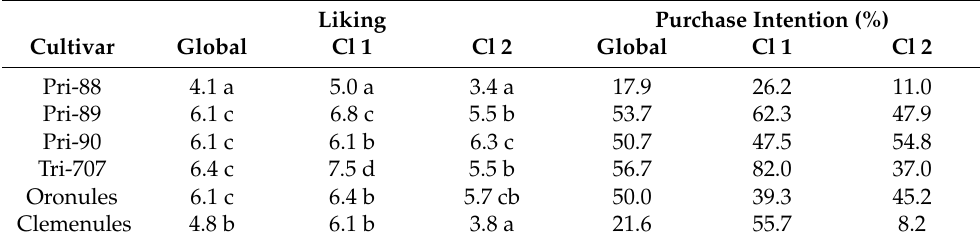
Table 3. Mean liking scores and purchase intention of all consumers (Global) and from cluster 1 (Cl1) and cluster 2 (Cl2) consumers. Liking Purchase Intention (%) Cultivar Global Cl